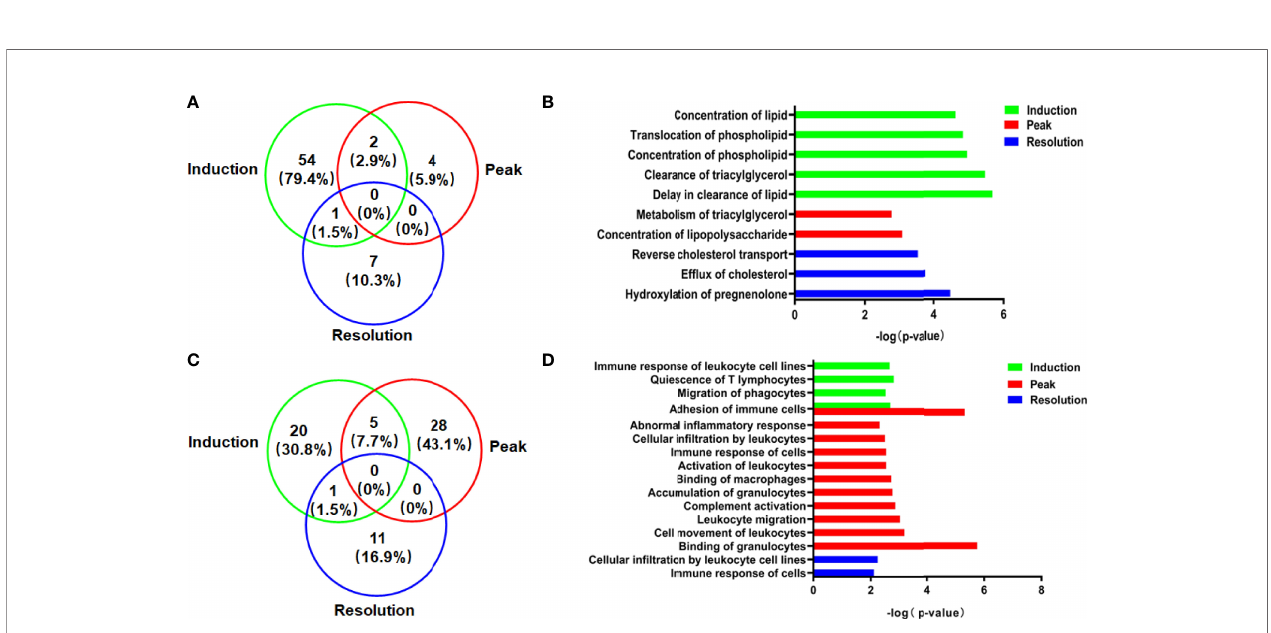
FIGURE 3 | The DEPs and function annotations related to lipid metabolism or immune function in the model group vs. the normal group in different phases. (A) The Venn diagrams showed the number and proportion of DEPs related to lipid metabolism. (B) The function annotations related to lipid metabolism showing enrichment of DEPs. (C) The Venn diagrams showed the number and proportion of DEP related to immune functions. (D) The function annotations related to immune function showing enrichment of DEPs.